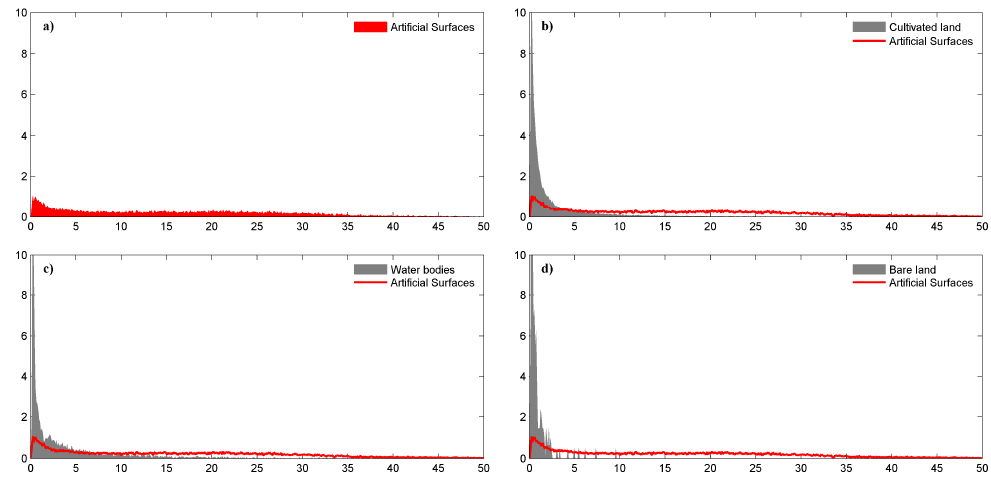
Figure 10. The distribution frequencies of the NDVI value of four easily confused land cover types: ( a ) artificial surfaces, ( b ) cultivated land, ( c ) water bodies and ( d ) bare land. The x -axis is the maximum NDVI value in 2012, and the y -axis is the distribution frequency.